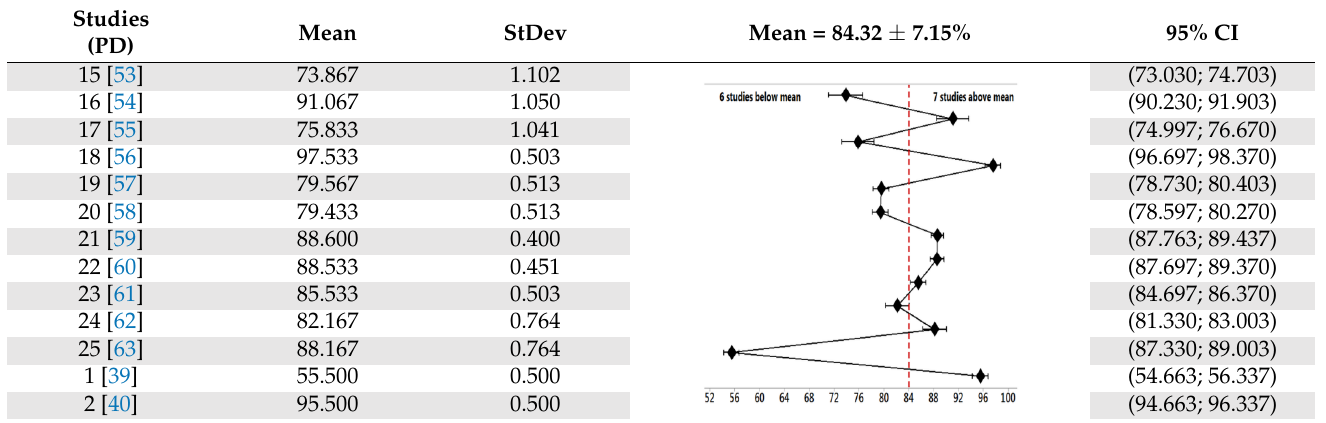
Table 7. Results of the statistical analysis of the accuracy (%) of identification and quantification by qPCR of miRNAs concerning PD, with p > 0.05 and no statistically significant difference, at CI 95%.